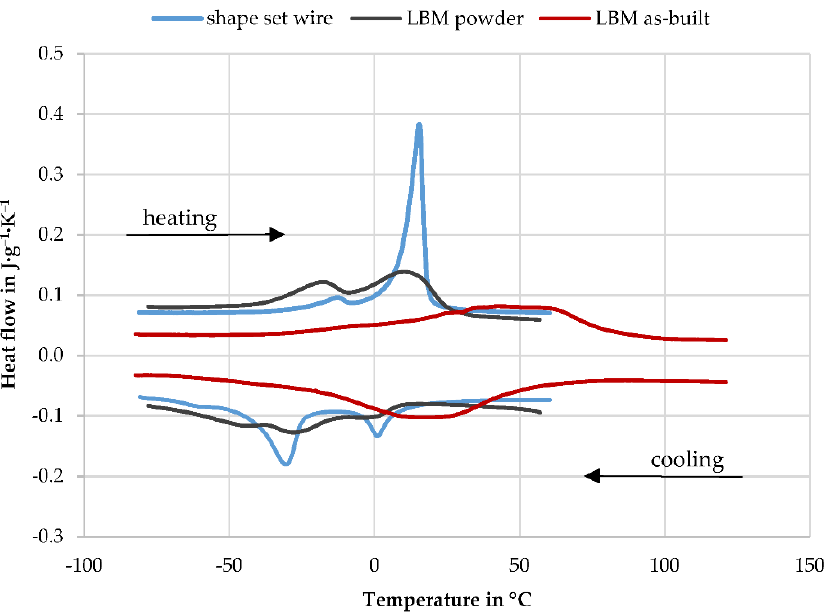
Figure 7. DSC thermograph of the shape-set wire, the unprocessed LBM powder, and the as-built LBM sample.